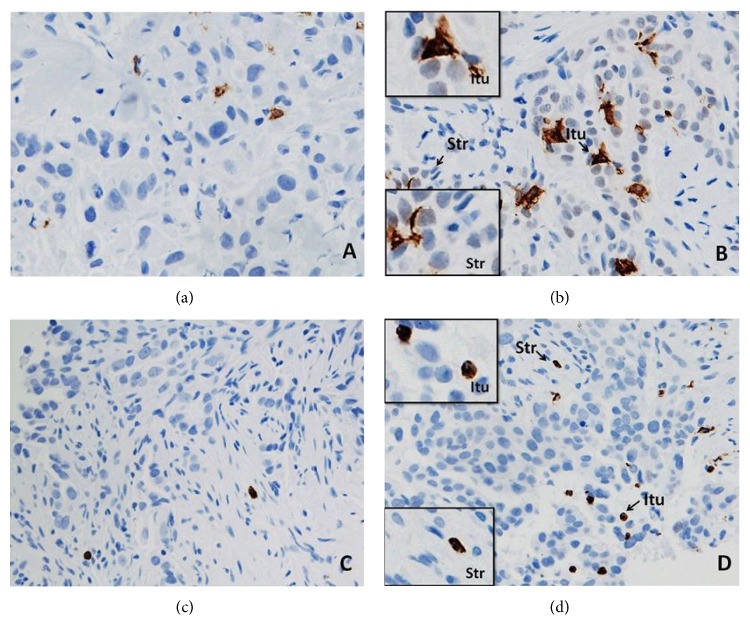
CD1a+ DCs (a, b) and CD66b+ neutrophils (c, d) in the sections of LLABCs, using IHC staining, at 400x magnification. Briefly, heat-mediated antigen retrieval was performed using citrate buffer, pH 6 (20 mins). The sections were then incubated with MAbs to CD1a (Dako, M3571) at a 1 : 200 dilution for 15 mins at RT, MAbs to CD66b (LSBio, LS-B7134) at a concentration of 10 μg/ml for 30 mins at RT. Polymeric HRP-linker antibody conjugate was used as secondary antibody. DAB chromogen was used to visualize the staining. The sections were counterstained with haematoxylin. (a, c) Low level of CD1a+ DC and CD66b+ neutrophil infiltration; (b, d) high level of CD1a+ DC and CD66b+ neutrophil infiltration. The total number of brown membrane-stained cells, regardless of intensity, in contact with tumour cells or within tumour cell nests (Itu: intratumoural) and in the interstitial stroma (Str: stromal/peritumoural) in 5 HPFs was counted.